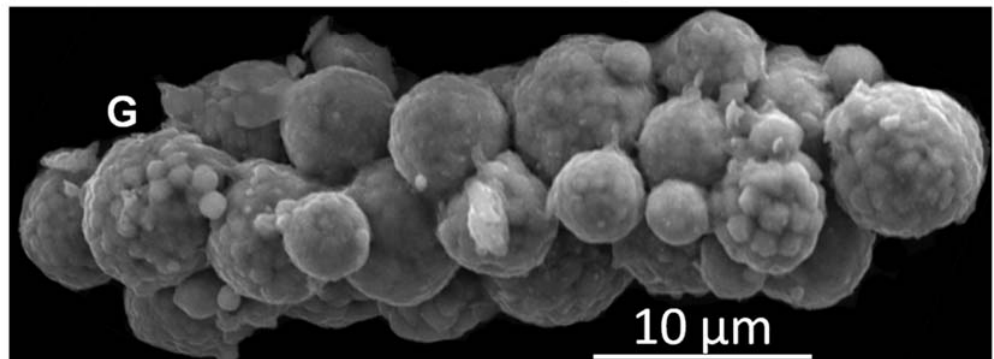
Figure A3. SEM images of different pyrite morphologies observed in the GC15 core: ( A ) octahedral 4 μ m wide pyrite crystals (sample: 151–152 cm depth, secondary electron mode, C coating); ( B ) loose aggregate of 1.5 μ m wide pyrite microcrystals (sample: 132–133 cm depth, back ‐ scattered electron mode, C coating); ( C ) 6 μ m wide framboidal pyrite composed of 0.6 to 1 μ m ‐ wide microcrystals (sample: 36–38 cm depth, secondary electron mode, Au metallisation); ( D ) 5 μ m wide framboidal pyrite composed of 0.4 μ m wide microcrystals (sample: 1–5 cm depth, secondary electron mode, C coating); ( E ) 9 μ m wide partially filled ‐ in framboidal pyrite composed of 0.8 μ m wide microcrystals (sample: 36–38 cm, secondary electron mode, Au metallisation); ( F ) 6 μ m wide filled ‐ in framboidal pyrite (sample: 54–56 cm depth, secondary electron mode, Au metallisation); ( G ) cluster including more than 25 framboidal pyrites from 2 to 7 μ m wide composed of multiple size microcrystals (e.g., 0.7 or 1.2 μ m), some framboids are filled ‐ in (sample: 186–187 cm, secondary electron mode, C coating).